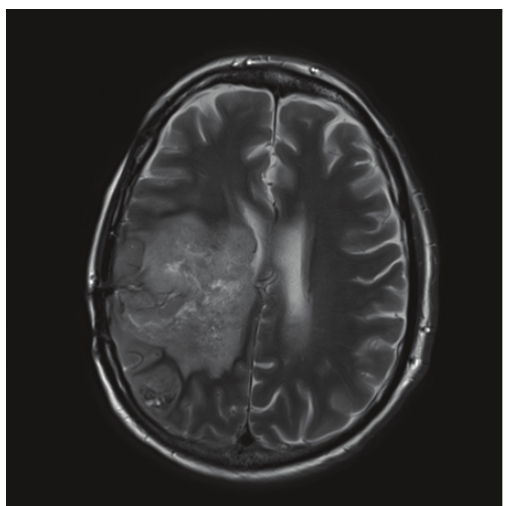
Figure 2: MRI of the brain, 6 weeks after embolectomy, showing stable